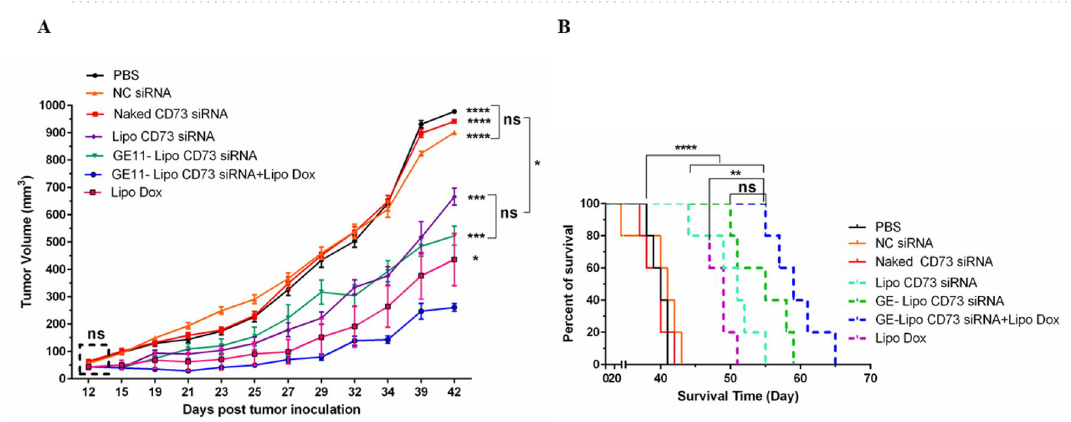
Figure 6. Therapeutic efficacy of liposomal CD73 siRNA, GE11-liposomal CD73 siRNA, liposomal doxorubicin, and GE11-liposomal CD73 siRNA+ liposomal doxorubicin combination in female BALB/c mice bearing 4T1 tumor. ( A ) Mean tumor volume in all groups. ( B ) Survival analysis of therapeutic groups (The log- rank test was used to analyze the survival). Data are expressed as mean ± standard deviation (n = 5). Statistically significant differences are represented as follows: * P < 0.05, ** P < 0.01, *** P < 0.001, **** P <